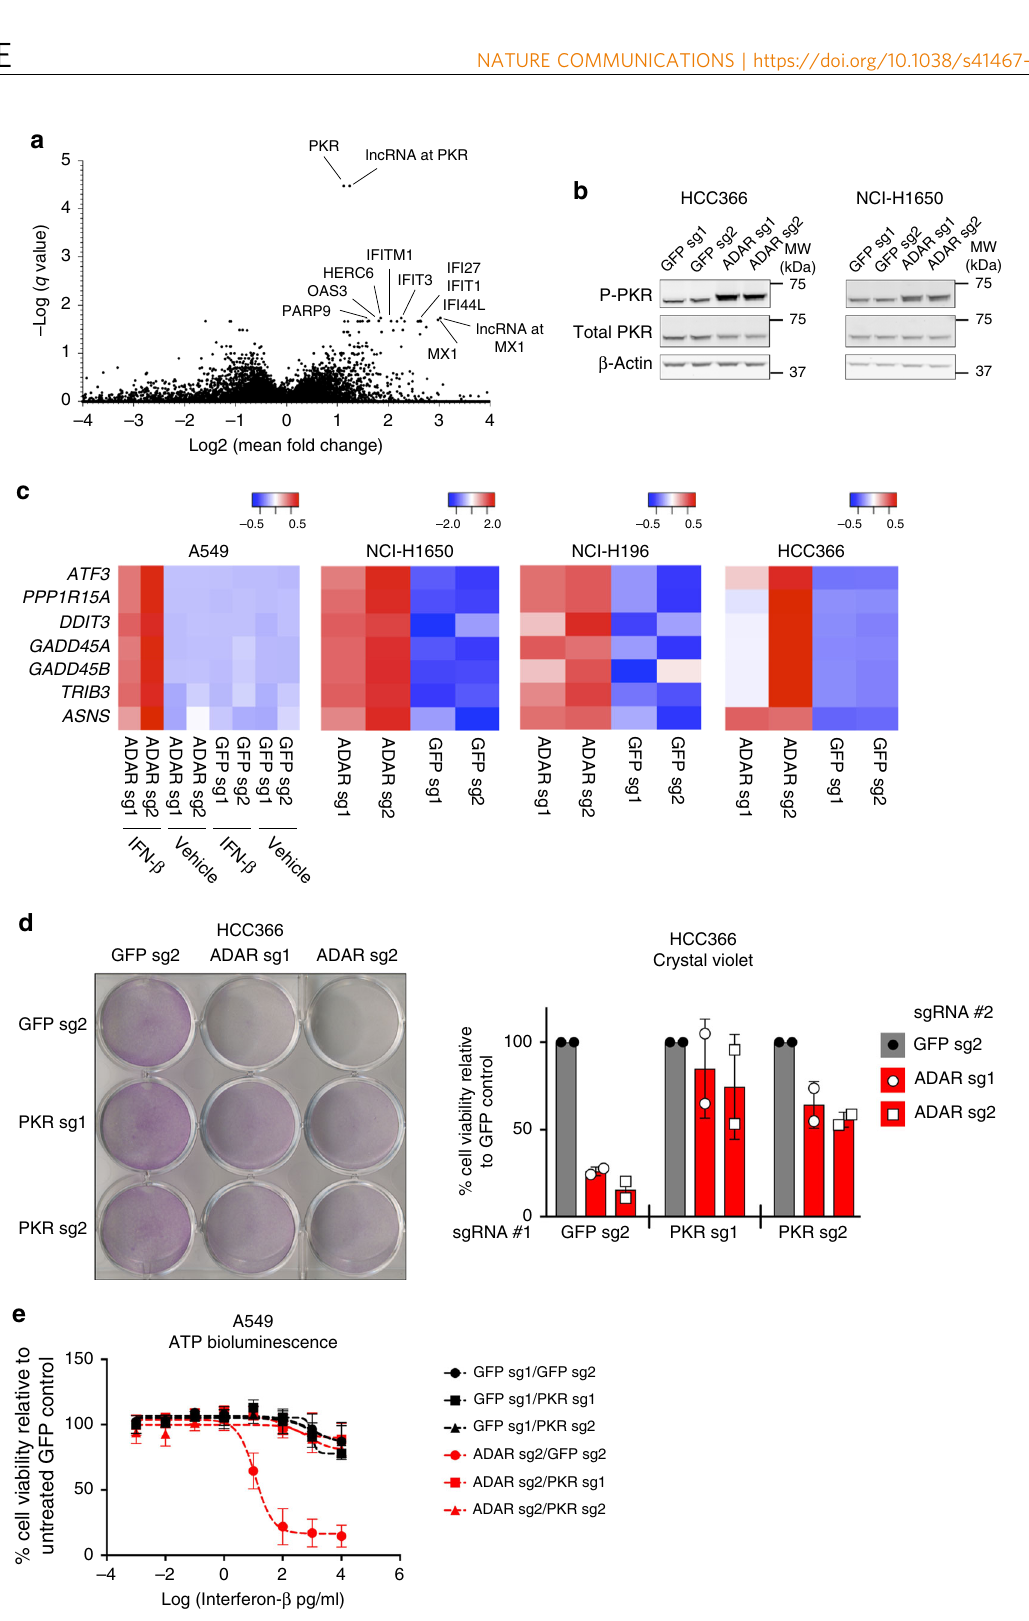
PKR activation and preventing cell lethality in ADAR1- dependent cancer cell